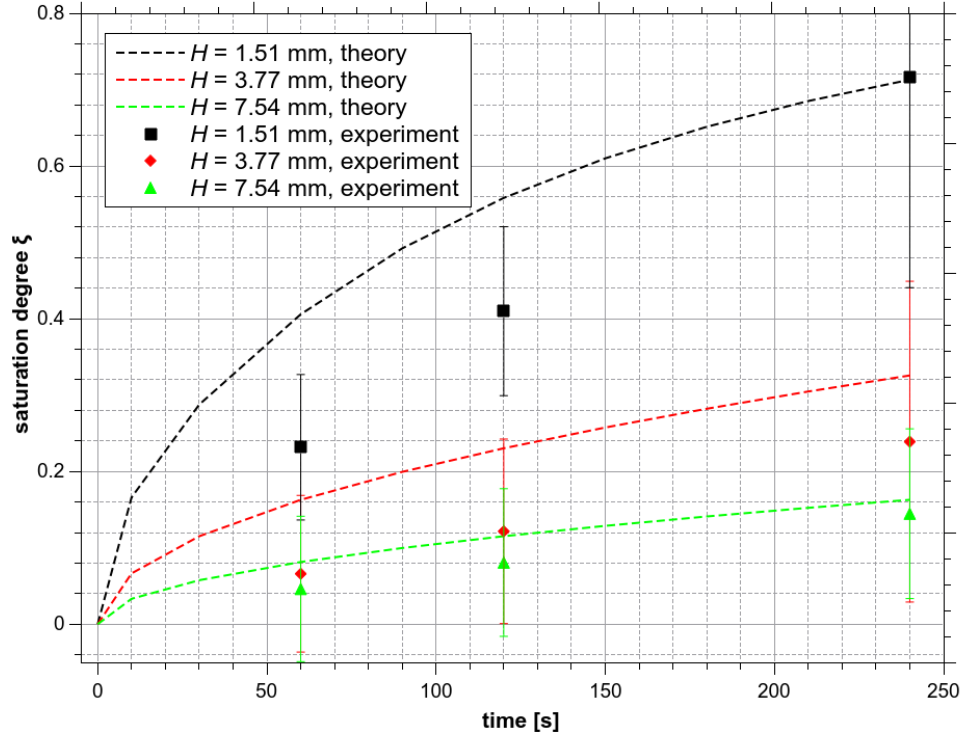
Figure 12. Saturation degree ξ O3 of O 3 as a function of treatment time and the bulk water depth H.